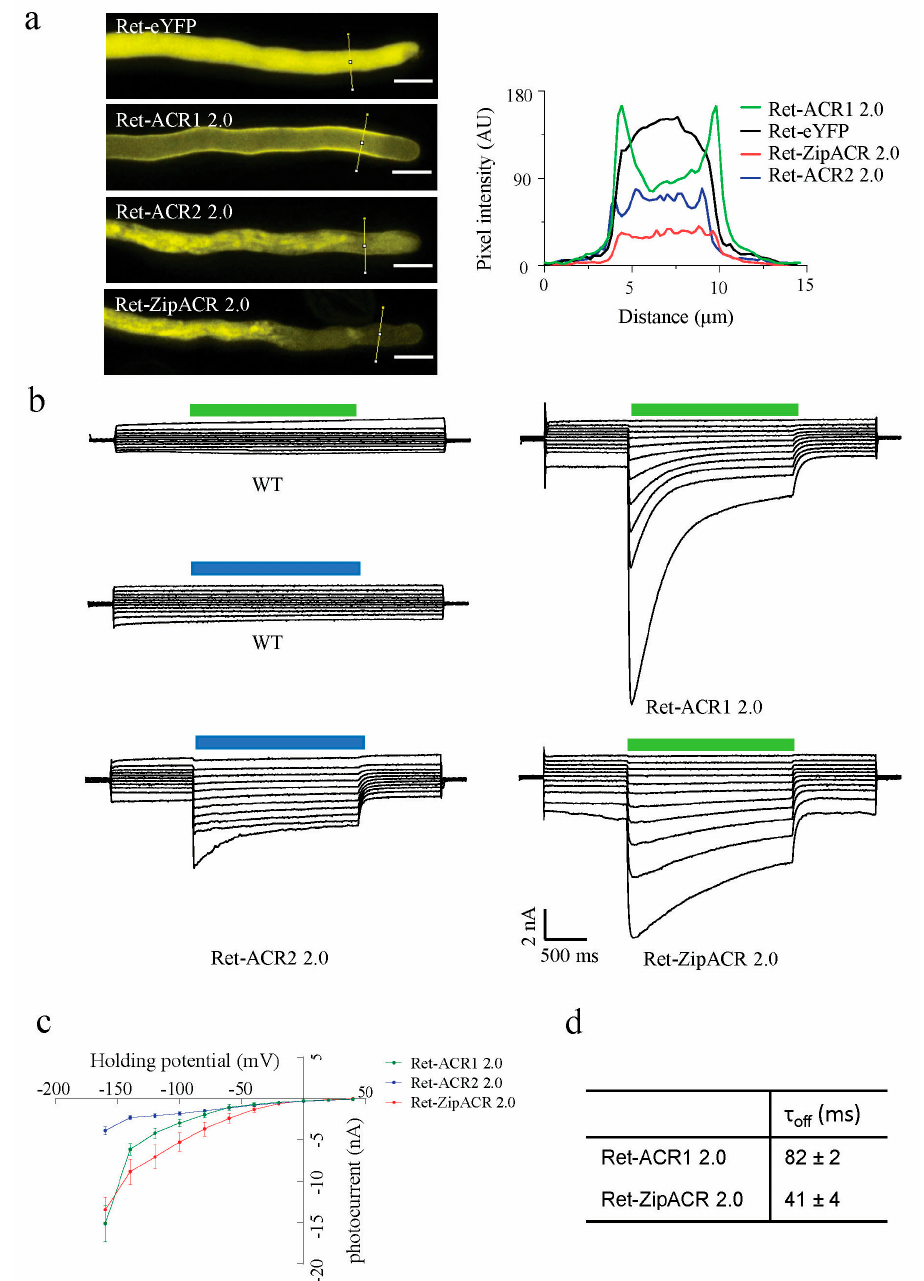
Figure 3. Functional expression of ACR2 and ZipACR in N. tabacum pollen tubes. ( a ) Representative confocal images of pollen tubes transiently expressing Ret-eYFP (n = 6), Ret-ACR1 2.0 (n = 6), Ret-ACR2 2.0 (n = 6) and Ret-ZipACR 2.0 (n = 6), the images were taken 5 h after transformation, scale bar = 10 µ m. For the analysis on the pixel intensity of the images on the right side, the line segments were drawn across the pollen tube images (left) and analyzed by Plot Profile (ImageJ). The x-axis represents the distance along the lines and the y-axis is the pixel intensity. ( b ) Representative photocurrent traces of wild- type (WT) tobacco pollen tubes and pollen tubes transiently expressing Ret-eYFP, Ret-ACR1 2.0, Ret-ACR2 2.0 and Ret-ZipACR 2.0 (all under UBQ10 promoter) in voltage-clamp recordings. Green bar indicates 2 s of 3.5 mW/mm 2 green light (532 nm), blue bar indicates 2 s of 4 mW/mm 2 blue light (473 nm) pulse. ( c ), Current-voltage relation of photocurrents in pollen tubes transiently expressing Ret-ACR1 2.0, Ret-ACR2 2.0 and Ret-ZipACR 2.0. Ret-ACR1 2.0 and Ret-ZipACR 2.0 were illuminated with 3.5 mW/mm 2 532 nm light, and Ret-ACR2 2.0 is illuminated with 4 mW/mm 2 473 nm light. Error bar = s.e.m, n = 5 cells. ( d ) For Ret-ACR1 2.0, τ off = 82.3 ± 2.21 ms. For ZipACR 2.0, τ off = 40.7 ± 3.8 ms. Data were obtained from measurements at − 80 mV and shown as mean ± s.e.m, n =